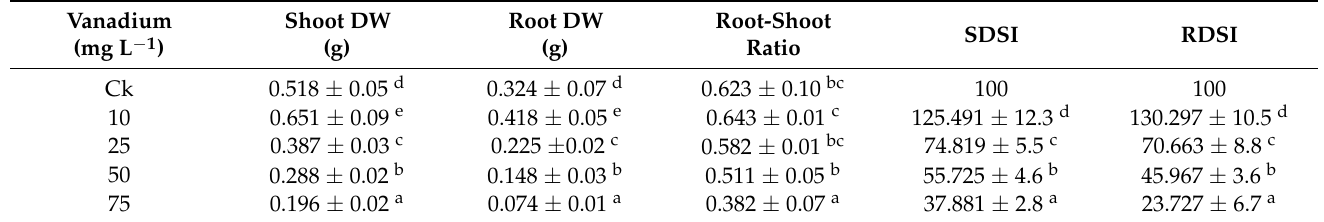
Table 2. The influence of various V treatments on root and shoot dry weight and root and shoot dry weight susceptibility index of sweet